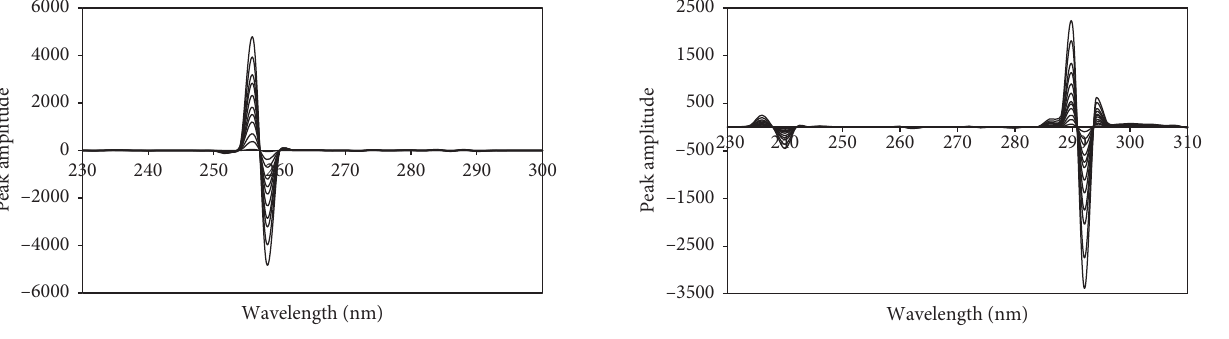
18, 20, 25, and 30 μ g/mL of carboxin in methanol at Δ λ � 2nm.